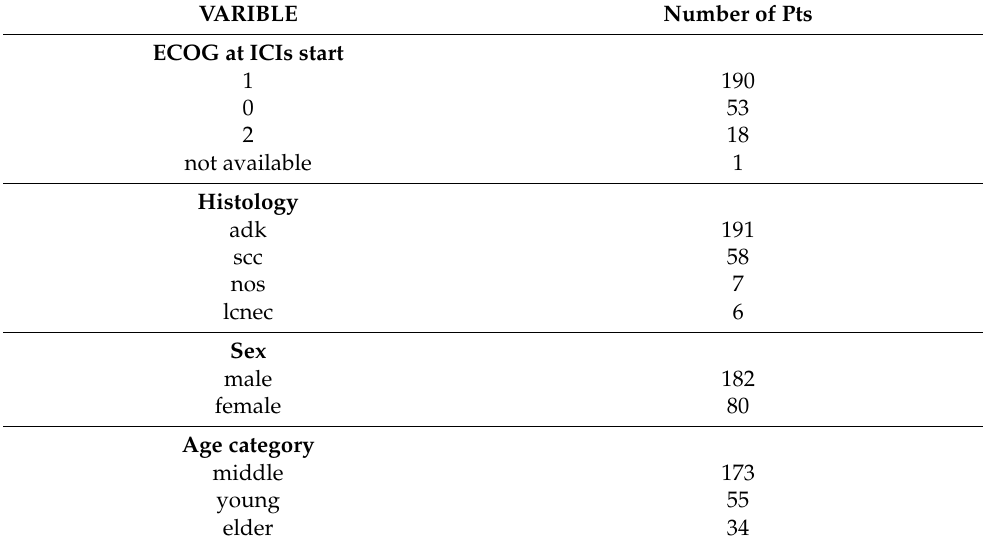
Table 1. Patients’ clinicopathological features